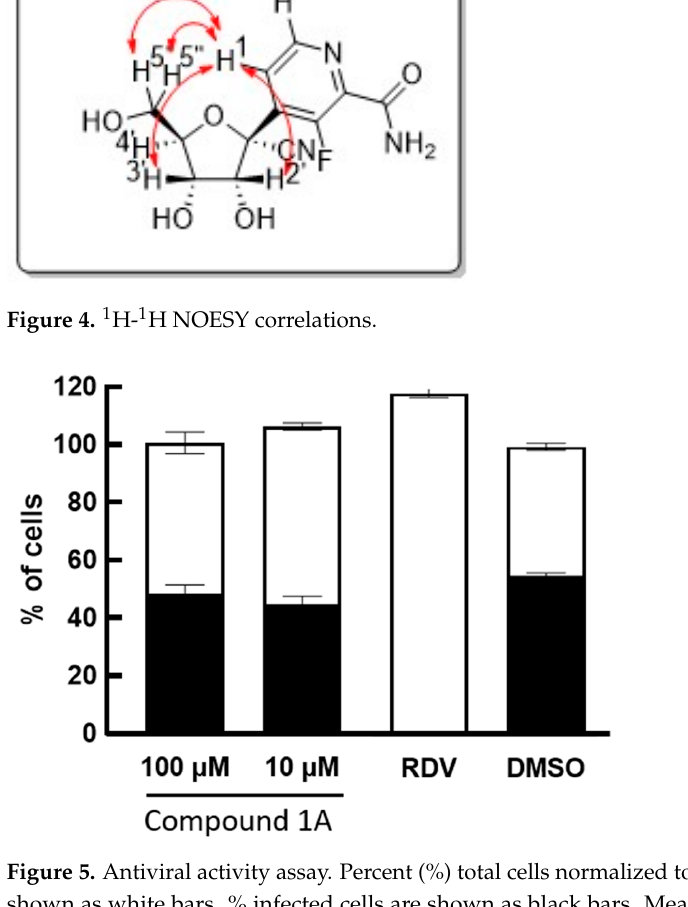
Figure 6. Cytotoxicity measurement.